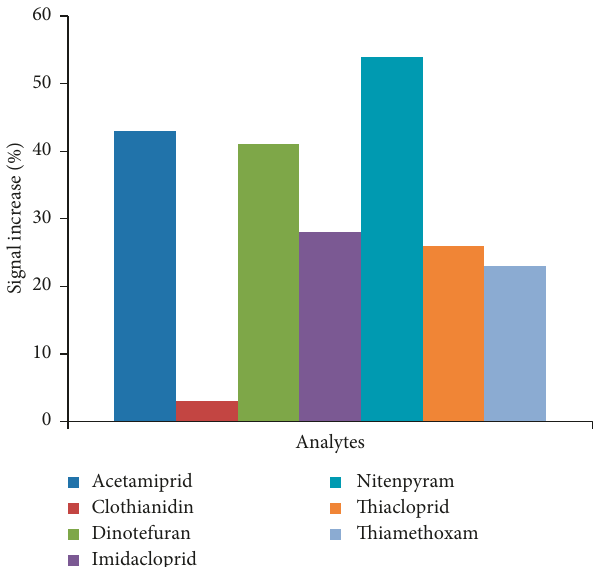
Figure 2: Signal increase, in percentage, when sodium dodecyl sulfate was used compared to the absence of the Table 2: Interference study carried out for 1 µ g · mL − 1 · NT. Foreign species